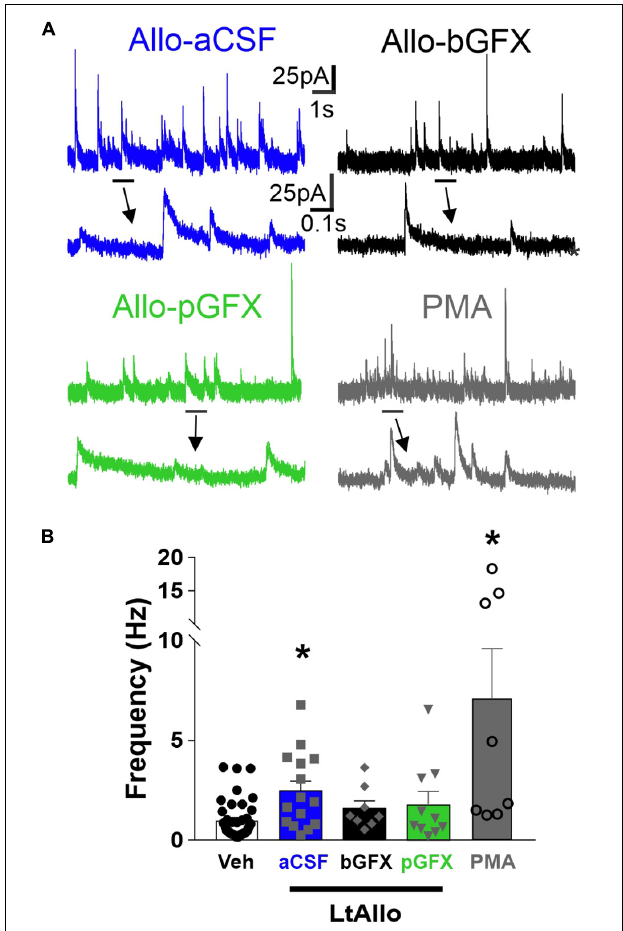
FIGURE 4 | PKC activation is both required and sufficient to increase IPSC frequency during LtAllo. (A) Representative mIPSC trace from DMV neurons after Allo-aCSF (blue trace), Allo-bGFX (black trace), Allo-pGFX (green trace), and PMA (gray trace). Line and arrow indicate section expanded below. (B) Mean ± SEM of mIPSCs frequency during Veh-treated and Allo-aCSF (duplicated from Figure 2F ), Allo-bGFX (1.6 ± 0.4 Hz; n = 8 from 3 mice), Allo-pGFX (1.8 ± 0.6 Hz; n = 10 from 7 mice), and PMA (7.1 ± 2.5 Hz; n = 8 from 6 mice). Kruskal-Wallis ANOVA with Dunn’s post hoc , * indicates significant differences from Veh. Significance indicates p ≤